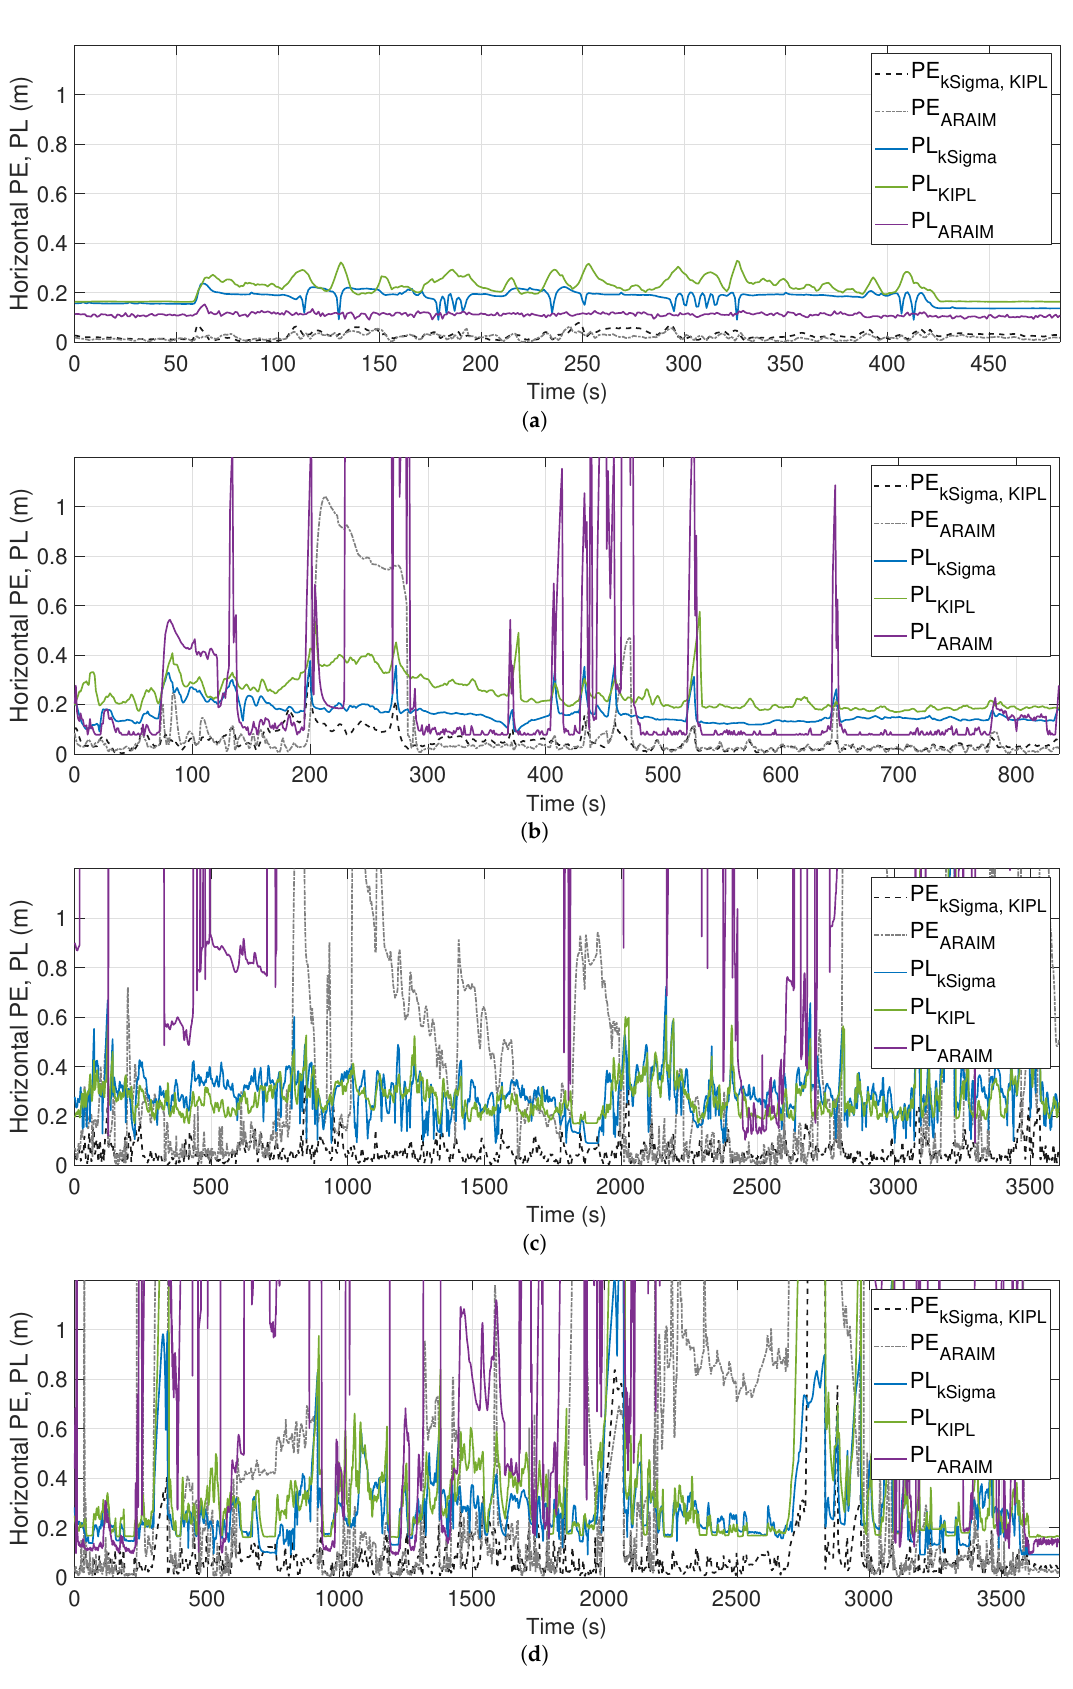
Figure 6. Comparison of the horizontal position error and the three implemented protection levels in the four selected scenarios: ( a ) airfield, ( b ) highway, ( c ) country road and ( d )